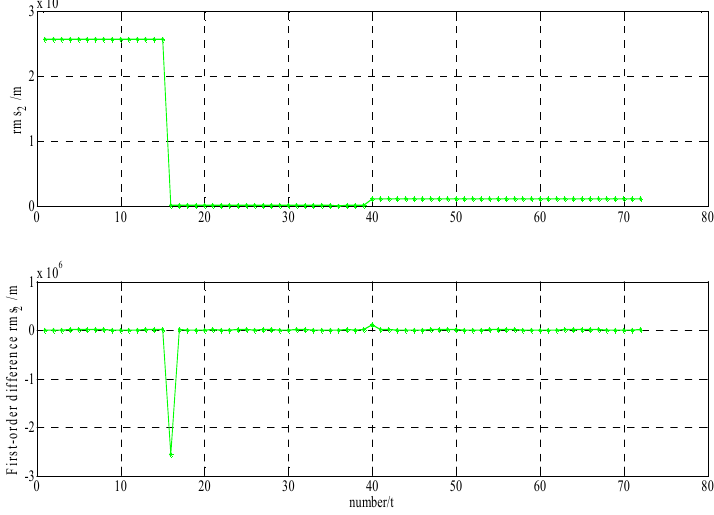
( ) rms t  . Figure 1. The results for rms ( t ) 2 2